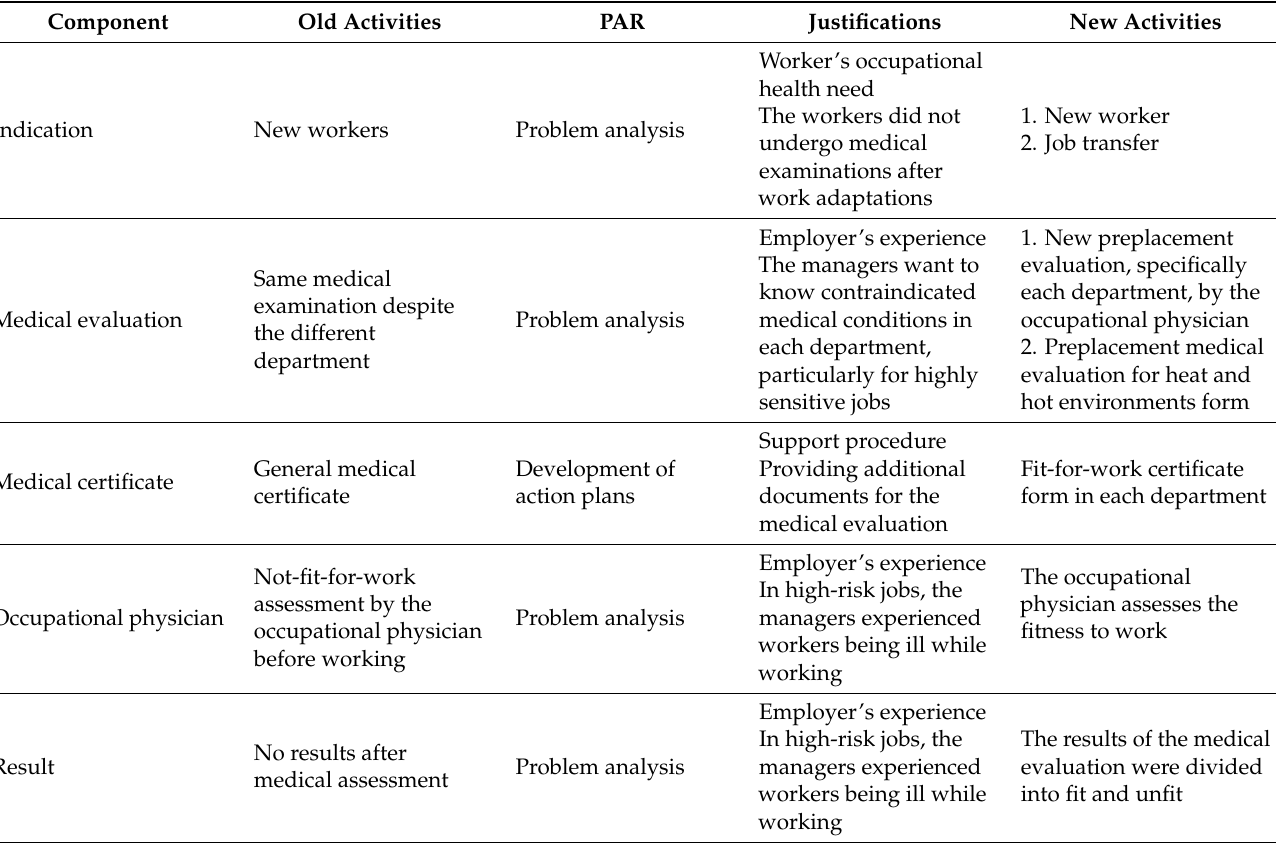
Table 11. Fit-for-work model